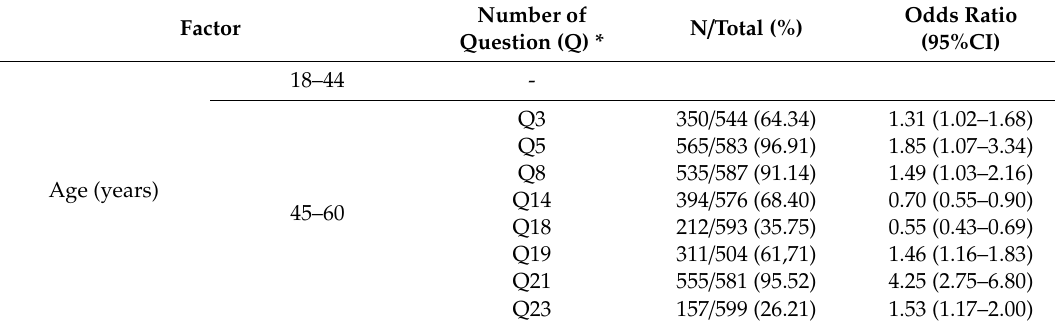
Table 4. Participants’ characteristics correlated with correct answers to the individual questions about knowledge, attitudes, and